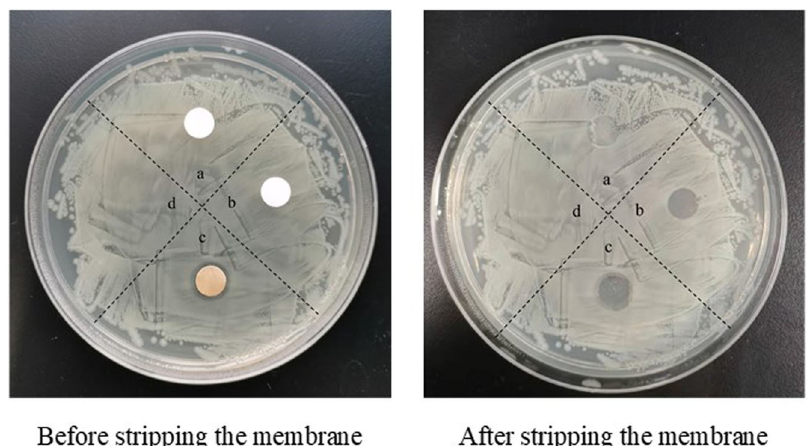
Fig. 8 a TFC, b H-SCNF-0.01, c H-SCNF/Ag-0.01 and d Blank bacteriostatic zone experiment, the diameter of the membrane was 8 mm, and the membrane was removed from the nutrient AGAR after 24 h culture.